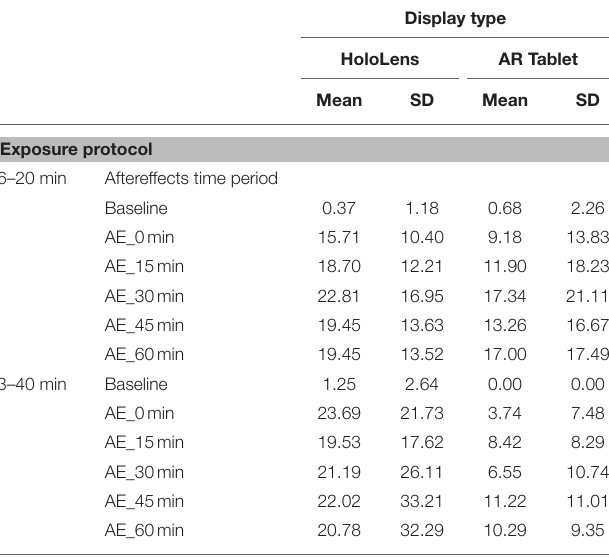
TABLE 1 | Total simulator sickness questionnaire total scores.